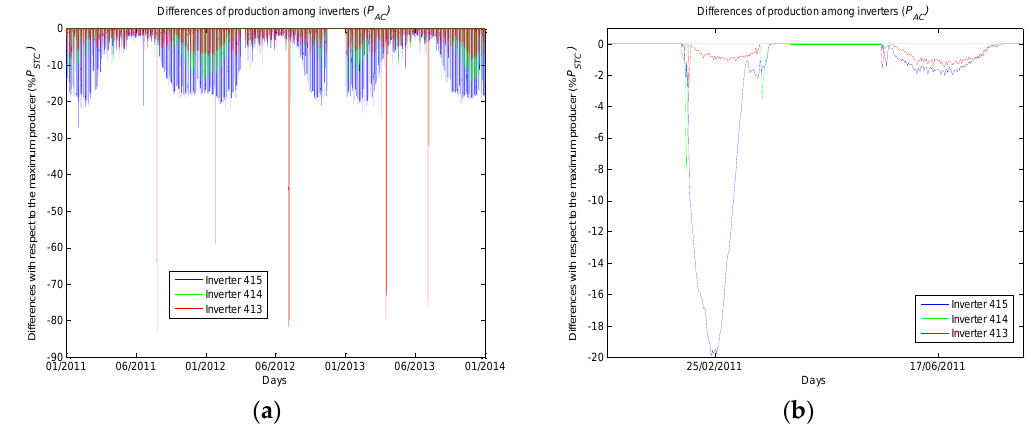
Figure 8. Instantaneous differences, in percentage of nominal power, of the production of each inverter with regard to that of the maximum production, in each instant of time: ( a ) from 1 January 2011 to 31 December 2013; and ( b ) on 25 February 2011 and on 17 June 2011.